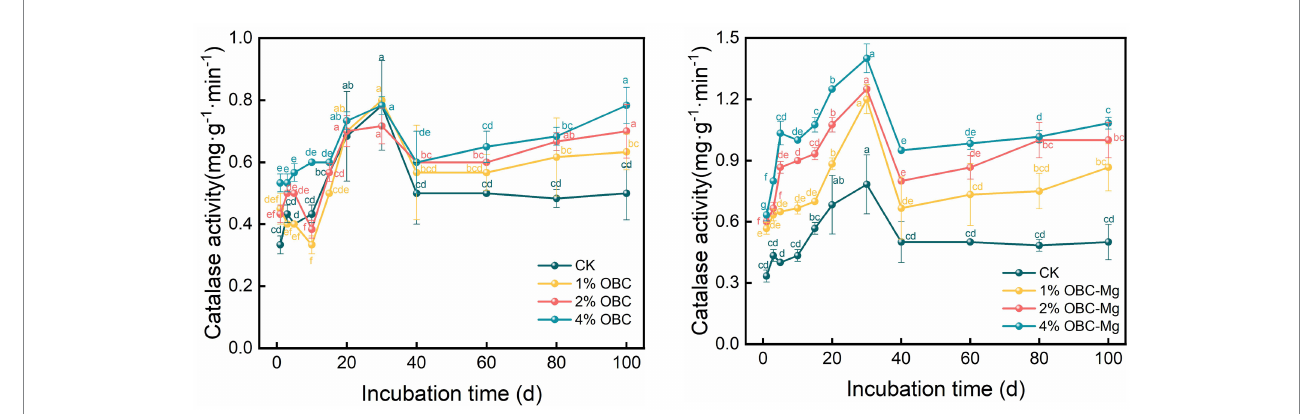
FIGURE 12 Changes in soil catalase activity after the amendment of OBC and OBC-Mg.